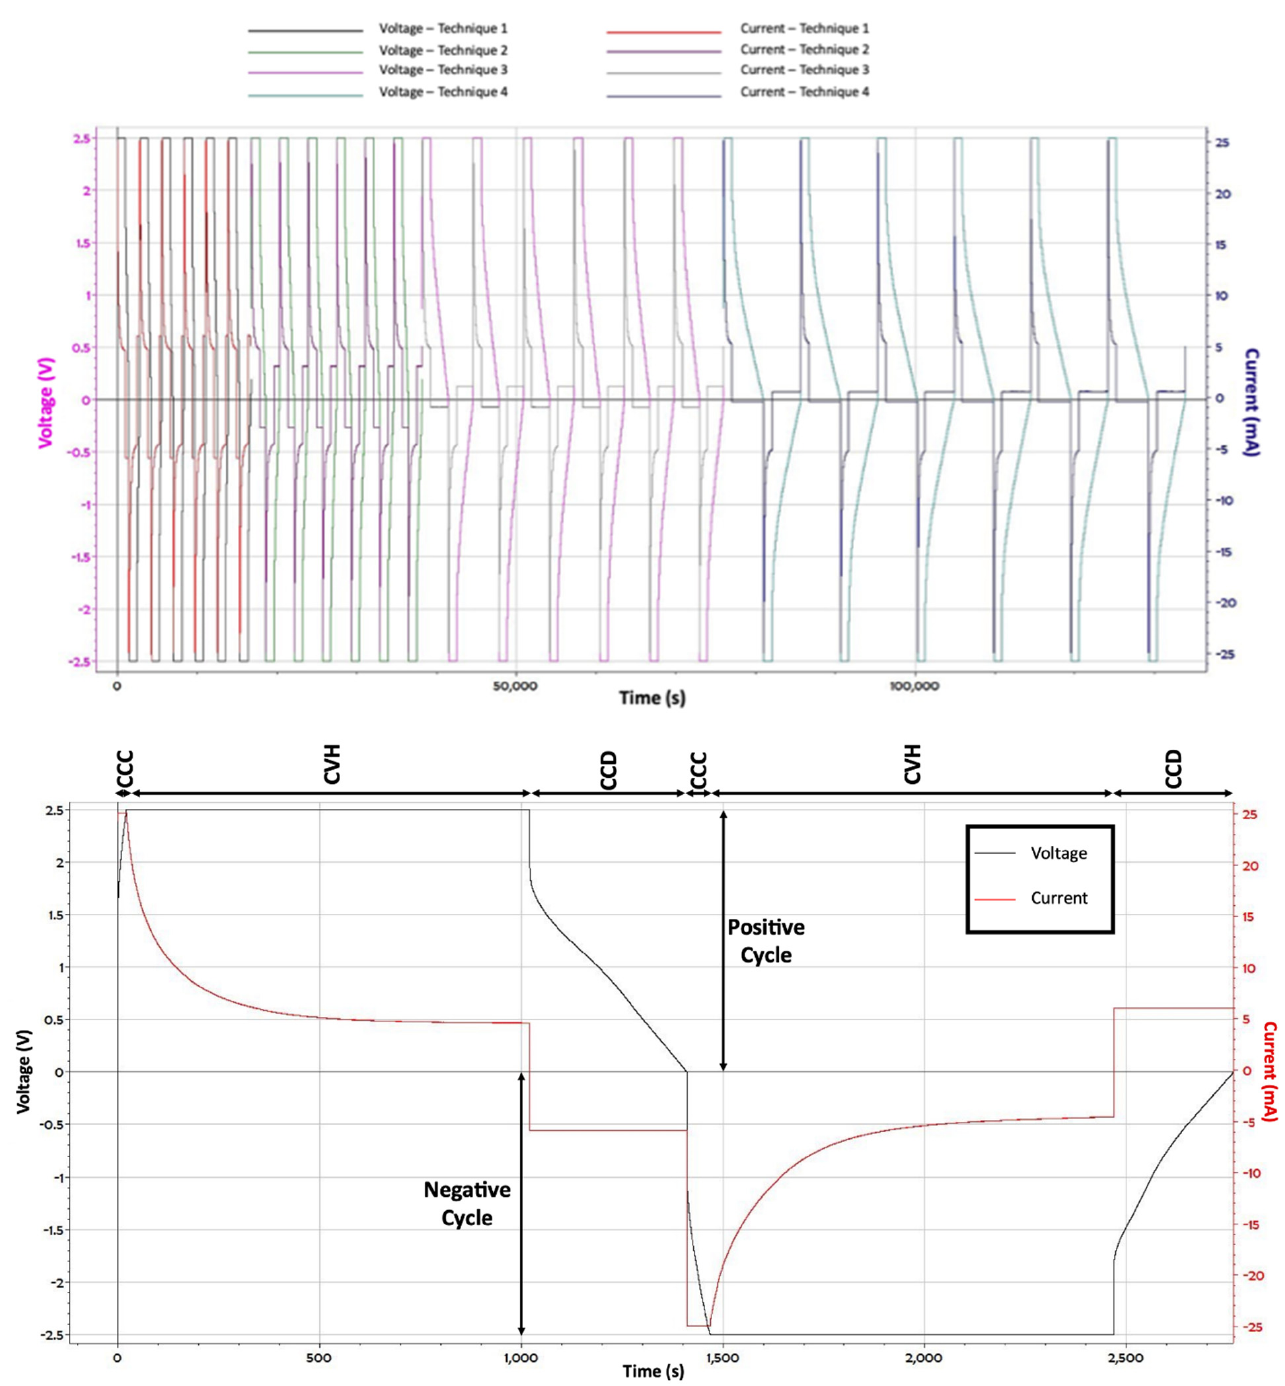
Figure 5. Example Full Data Set for One Capacitor: Top: All the data from one capacitor: four discharge currents and six cycles of each (Table 1). Bottom: An expansion of data showing a single cycle. Note: Theoretically, for a capacitor of constant capacitance, the discharge is linear with time. For these capacitors, that was approximately true below ~1.9 Volts. Above that value, voltage dropped sharply, and little energy was delivered to the load.